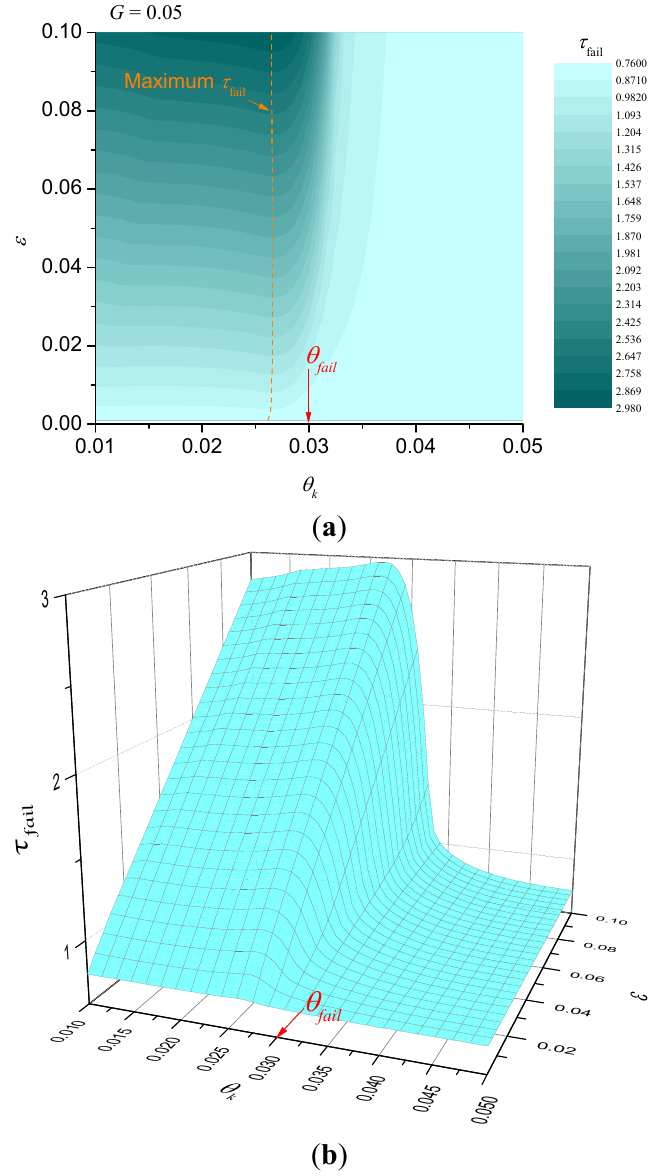
Figure 3. Illustration of dimensionless failure time for G = 0.05 (failure at unexposed surface). ( a ) contour plot; ( b ) surface